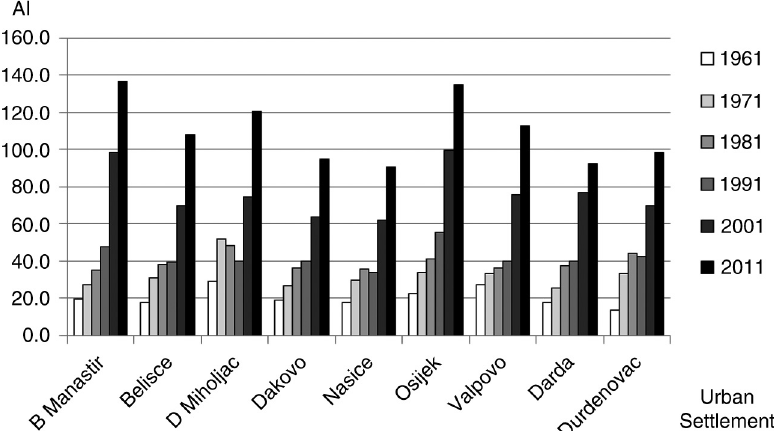
Figure 1. Ageing index of the urban settlements in the period 1961 (cid:2) 2001. Source : CBS